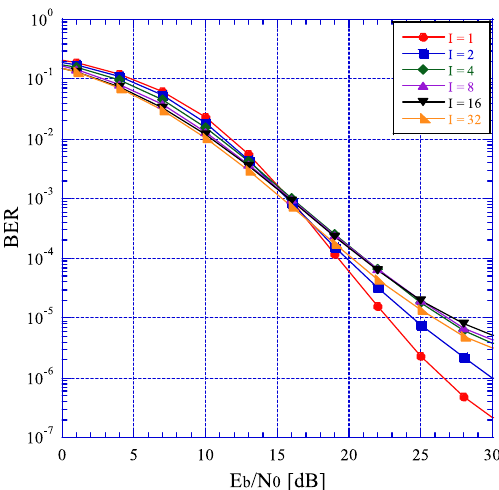
Fig. 10 BER of the various E b / N 0 for the interleaved block subcarrier allocation with the DFT and the MMSE, without the